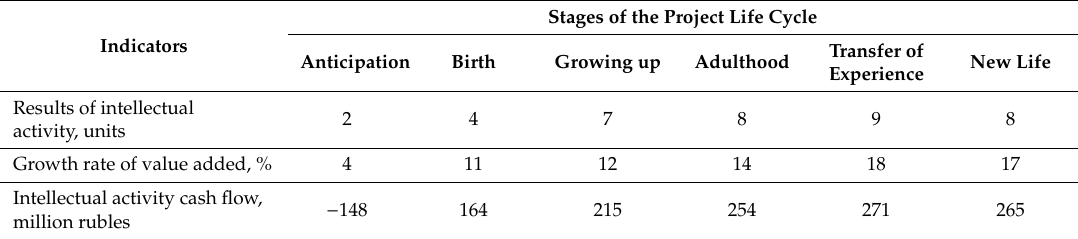
Table 6. Assessment of the project for the development of digital production technologies for industrial machinery and